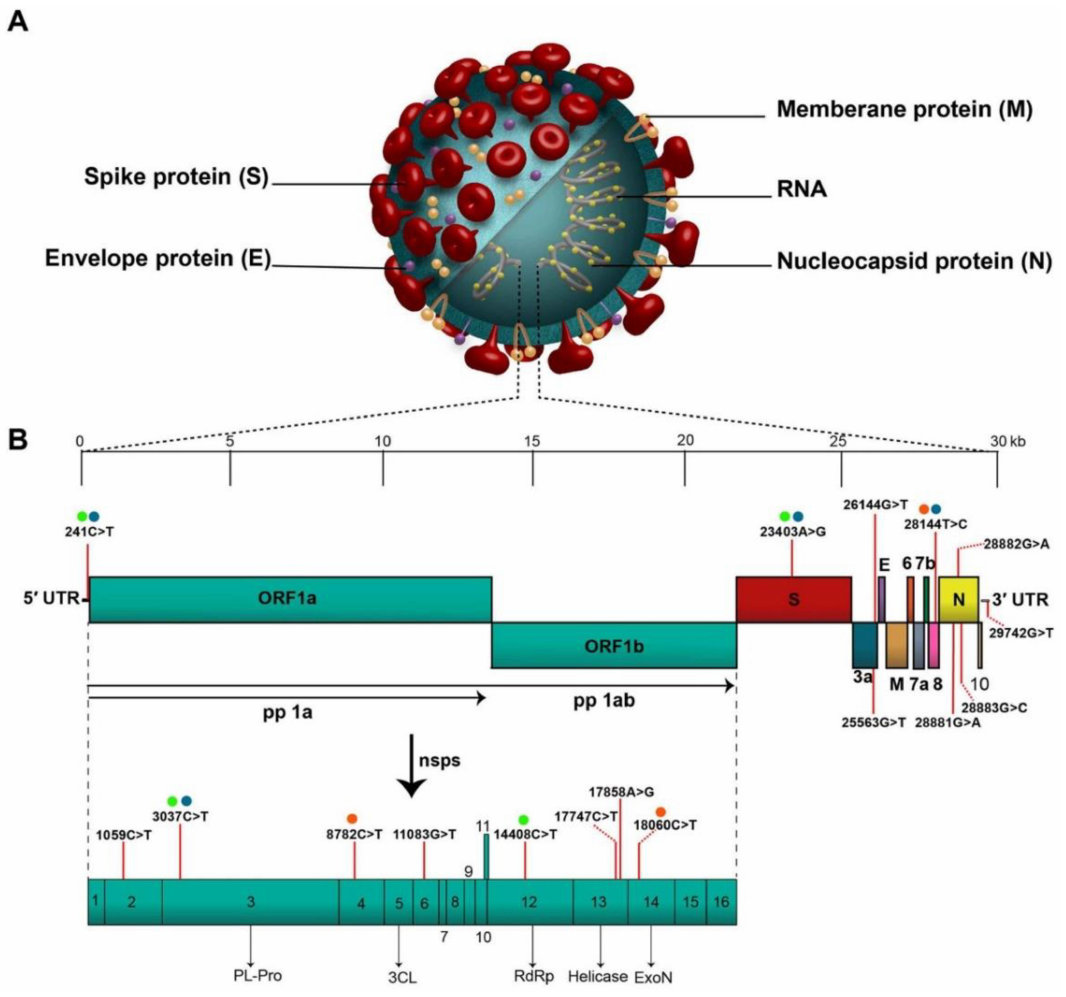
Figure 1. Novel coronavirus structure and genomic backbone. “( A ). Structure of SARS-CoV-2 and ( B ). The SARS-CoV-2 genome (29,903 nucleotides) comprises the 5 (cid:48) UTR, ORF1a/b encoding 16 nsps for replication, four genes that encode structural proteins including S, E, M, and N proteins, six accessory genes that encode six accessory proteins such as ORF3a, ORF6, ORF7a, ORF7b, ORF8, and ORF10, as well as the 3 (cid:48) UTR. The location of the seventeen high-frequency mutations and co-mutations reported in the literature are shown on the genome by vertical red lines and circles with similar color, respectively. Abbreviations: SARS-CoV-2, severe acute respiratory syndrome coronavirus 2; 5 (cid:48) UTR, 5 (cid:48) untranslated region; OFR, open reading frame; nsp, non-structural protein.” (Reprint with permission from